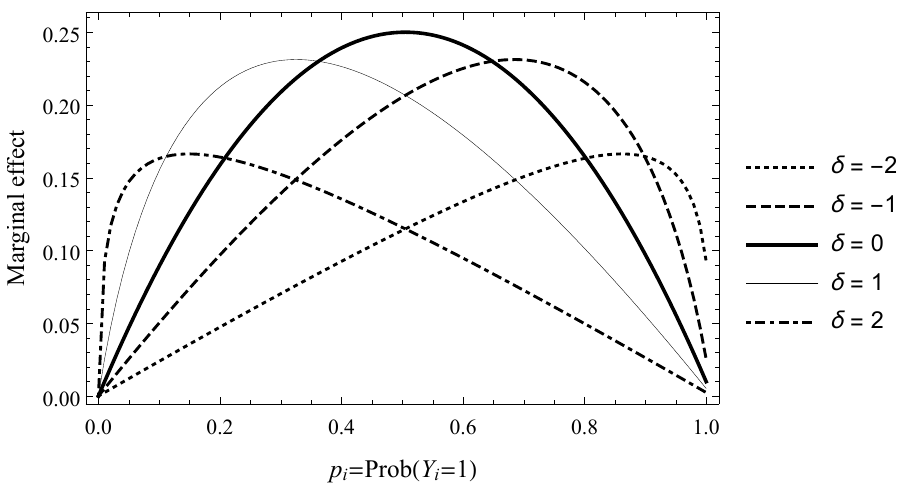
Figure 2. Marginal effect of the skewed logit model with different values of skewness parameter δ . The case δ = 0 corresponds to the classical logistic